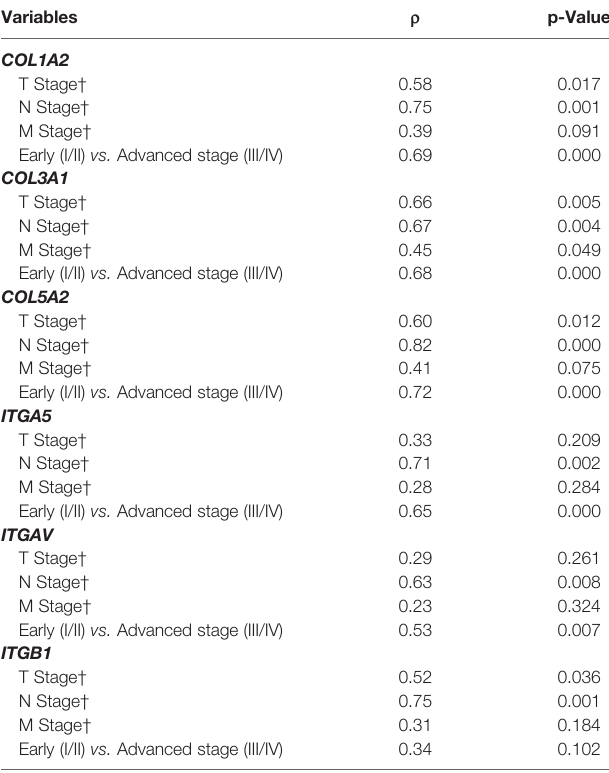
TABLE 4 | Statistical analysis by non-parametric Spearman ’ s rank correlation coef fi cient (P<0.05) between COL and ITG gene expression and the disease progression pro fi